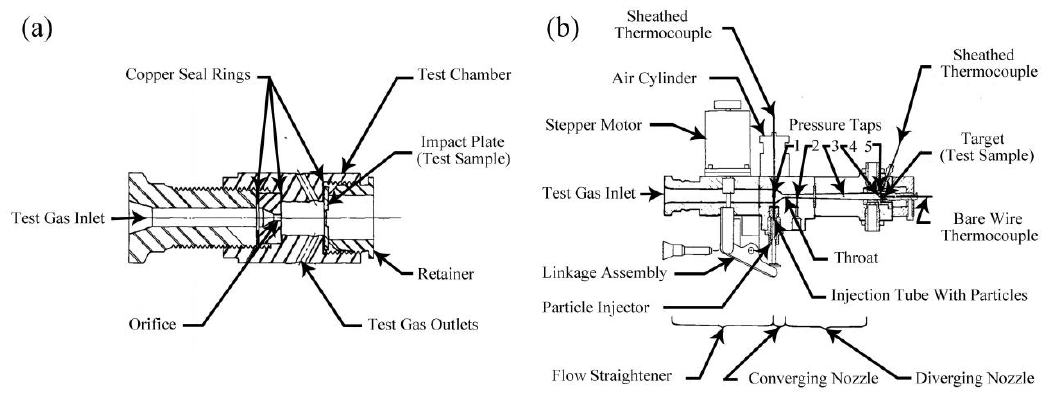
Figure 5. ( a ) First generation sonic velocity impact chamber; ( b ) ameliorated sonic velocity impact facility, reproduced from [50] with permission from ASTM,